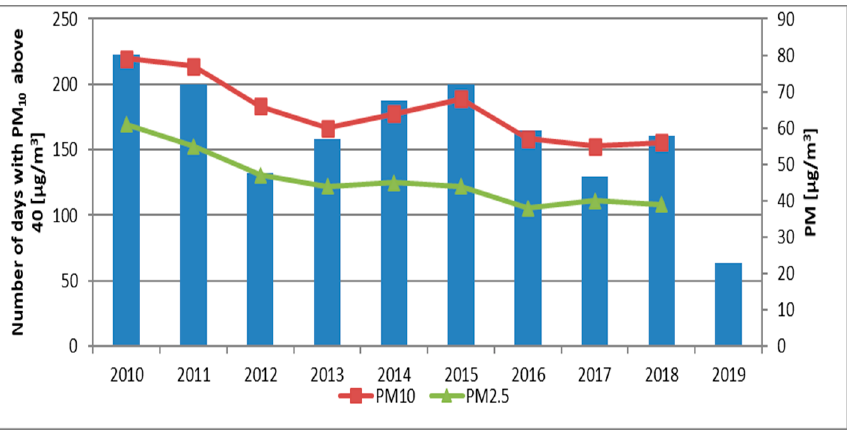
Figure 3. Days per year with exceeded norms of PM 10 for Krakow agglomeration and PM 10 , PM 2.5 concentrations at Krasinskiego.